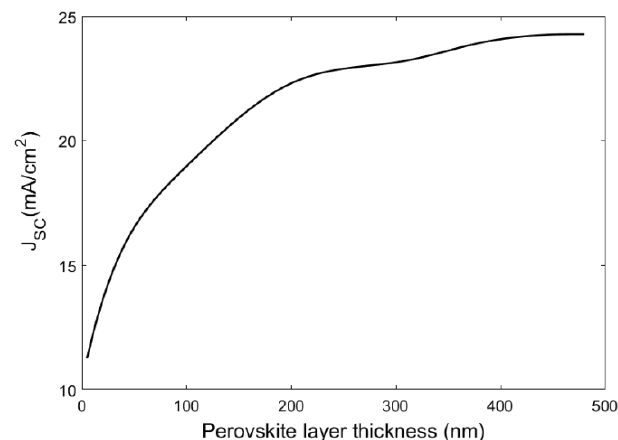
Figure 4. J SC vs. perovskite layer thickness for the planar structure.